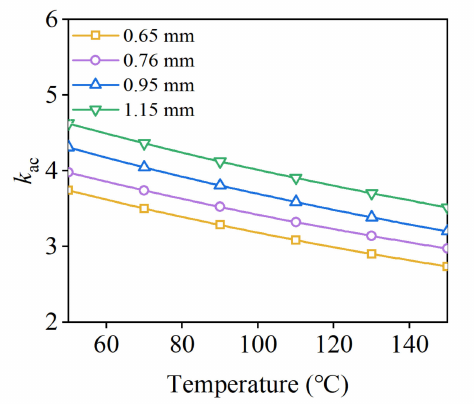
Figure 26. AC/DC copper loss ratio k ac with conductor diameter at different temperatures.